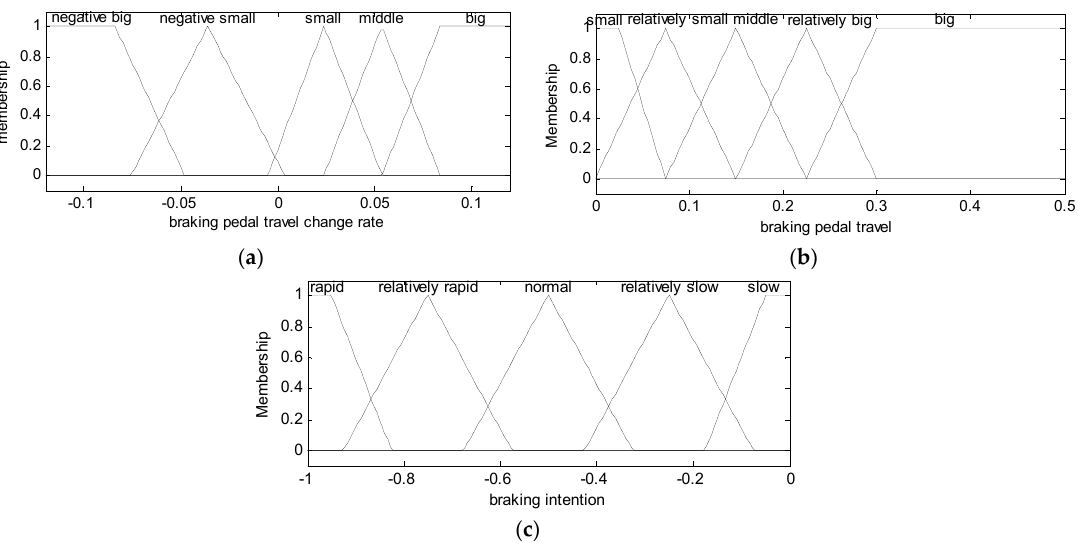
Figure 5. ( a ) Membership functions of braking pedal travel; ( b ) membership functions of rate of change of braking pedal travel; and ( c ) membership functions of braking intention. Table 2. The fuzzy rules for identification of the braking intention.